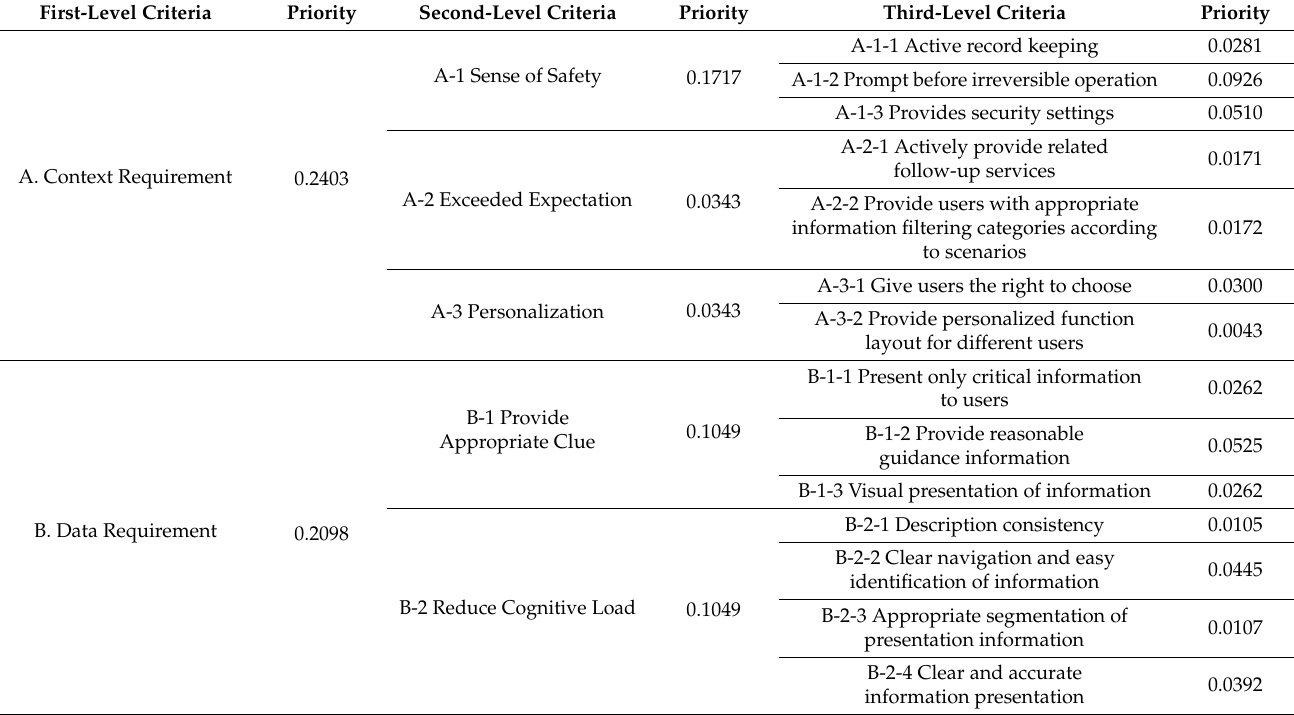
Table 3. The UX measurement